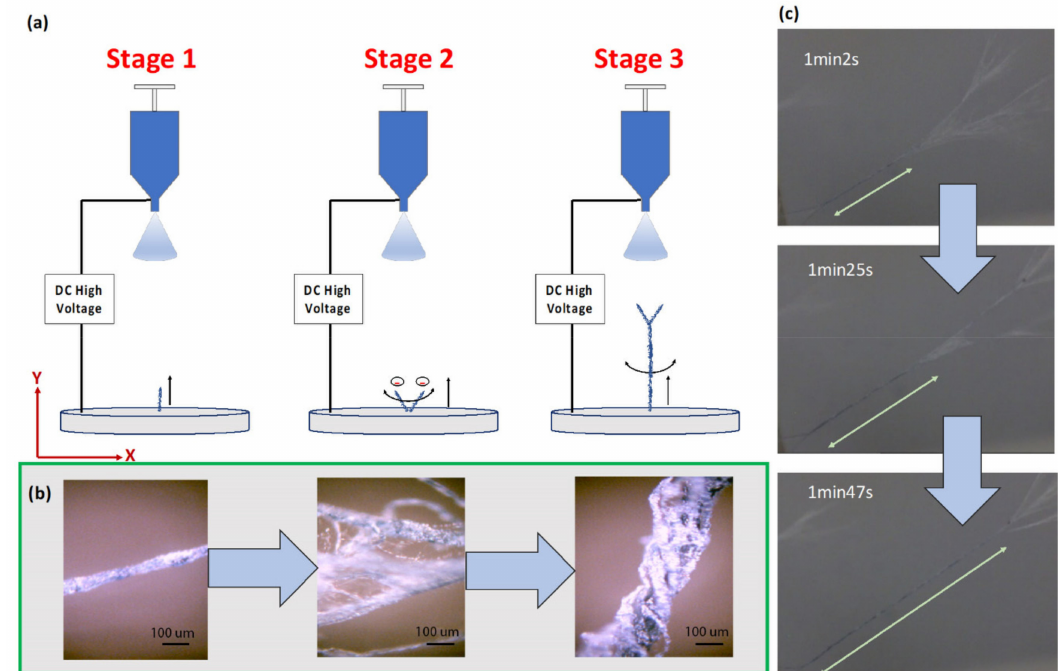
Figure 1. ( a ) Schematic diagram of nanofiber yarn formation. Stage 1: Individual standing fibers populate the collector plate and lengthen. Stage 2: Fiber bundles twist from electrostatic and mechanical forces to form yarn with neighboring fibers. Stage 3: Newly spun nanofibers attach to the growing yarn structure and continue to twist about the longitudinal axis. ( b ) Structural transformation from a single fiber to a yarn, demonstrating collection of single fibers into an organized structure in stage 2 and 3. (Scale bar: 100) ( c ) Time lapse sequence of stage 3 nanofiber yarn formation at 62, 85 and 107